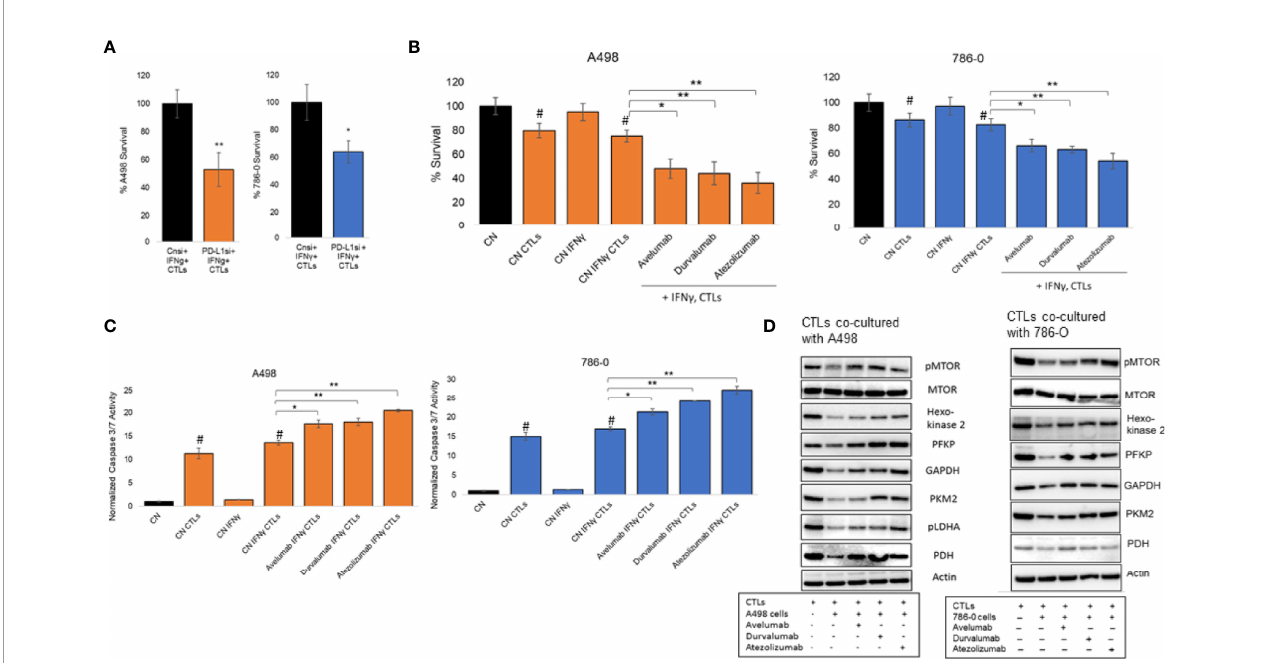
FIGURE 5 | Modulation of PD-L1 in co-culture model. (A) Silencing of inducible expression of PD-L1 in A498 and 786-O in co-culture with CTLs decreases their viability. The data are presented as mean ± SD (n=3) *p<0.05, **p<0.001. (B) A498 and 786-O cells were co-cultured with CTLs in the presence absence of therapeutic monoclonal antibodies blocking PD-L1, avelumab, durvalumab and atezolizumab, at a concentration of 20 m g/ml for 24 hours (A498) or 48 hours (786-O). The data are presented as mean ± SD (n=3) *p<0.05, **p<0.001, # p<0.05 for CN compared to CN CTLs (with and without IFN g ). (C) Caspase 3/7 activity was increased in A498 and 786-O cells co-cultured with CTLs in the presence of avelumab, durvalumab and atezolizumab at 20 m g/ml concentration for 24 hours (A498) and 48 hours (786-O). The data are presented as mean ± SD (n=3) *p<0.05, **p<0.001, # p<0.05 for CN compared to CN CTLs (with and without IFN g ). (D) CTLs used for the co-culture experiments described above were then isolated to extract their protein content and analyse the expression of glycolytic enzymes, PDH and MTOR activity by immunoblotting (n=1). Densitometric analysis is shown in Supplemental Figure 3